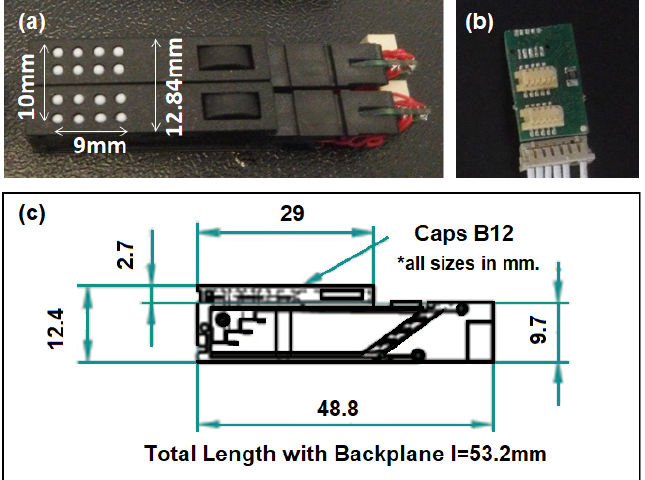
Figure 5. P20 Braille cell. ( a ) The 4 × 4 matrix from two pieces of P20 Braille cells, ( b ) two-position backplane for two P20 Braille cells, and ( c ) P20 side-view dimensions